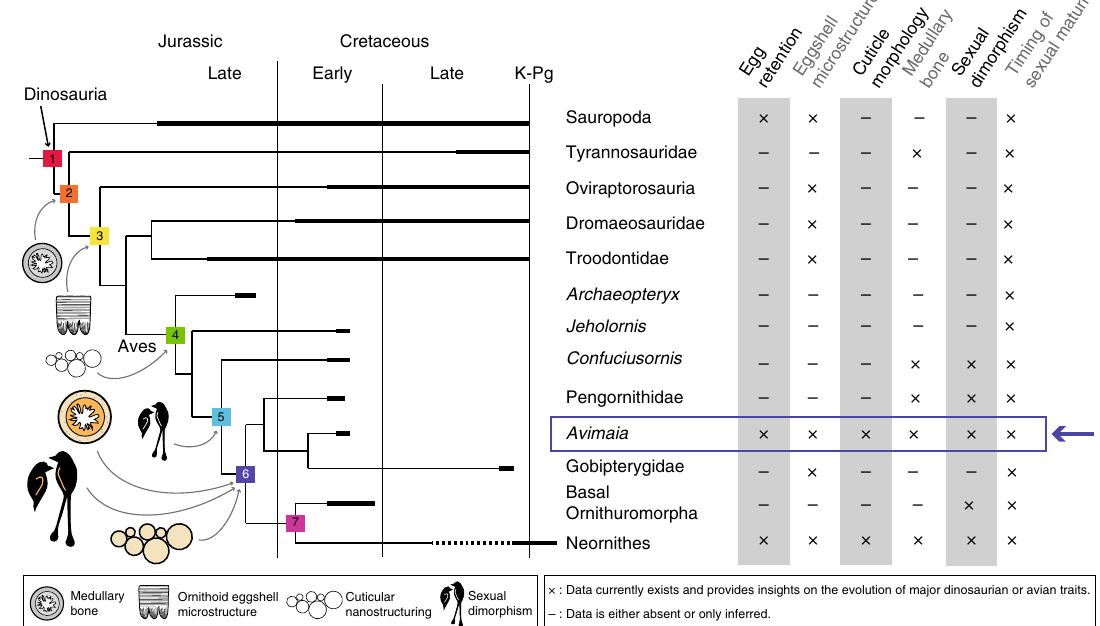
Fig. 5 Simpli fi ed phylogeny with hypothetical evolutionary stages of modern avian reproduction. Stage 1: Plesiomorphic dinosaurian condition: abnormal multilayered eggshells due to egg retention can occur 34 , dinosauroid eggshell microstructure 35 , possible sexual dimorphism 75 , strong histological evidence for sexual maturity occurring prior to skeletal maturity 63 . Stage 2: Possible appearance of medullary bone 4,8 . Stage 3: Possible appearance of ornithoid eggshell microstructure 35 . Stage 4: Possible appearance of cuticular nanostructuring 21 . Stage 5: Strong evidence for sexual dimorphism (inferred